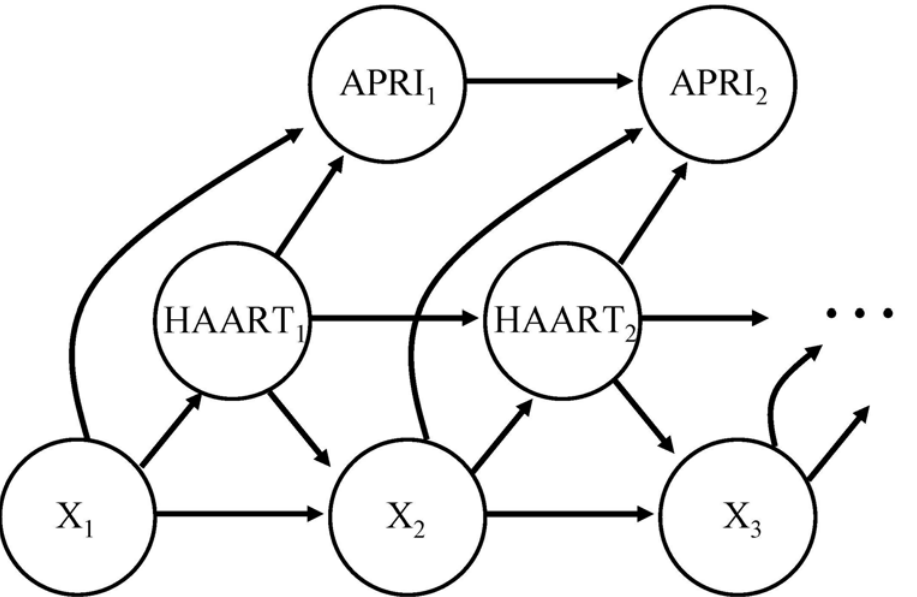
Figure 1. Postulated causal diagram. A directed acyclic graph of the relationship between HAART exposure and APRI over time, where potentially confounding variables such as, for example, CD4 + T-cell counts, are represented by X. The Generalized Propensity Score permits unbiased estimation of the direct (or cross-sectional) effect, a , of most recent HAART intake on the response.